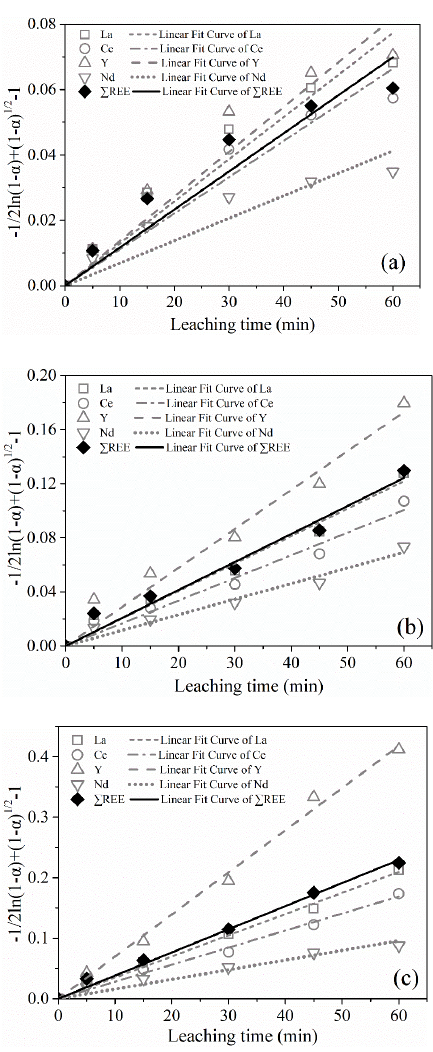
Figure 13. Variance of −1/2ln(1 − α) + (1 − α) 1/2 − 1 between the experimental data and model predictions as a function of leaching time at different leaching temperatures (( a ), 30 °C; ( b ), 60 °C; ( c ), 80 °C).